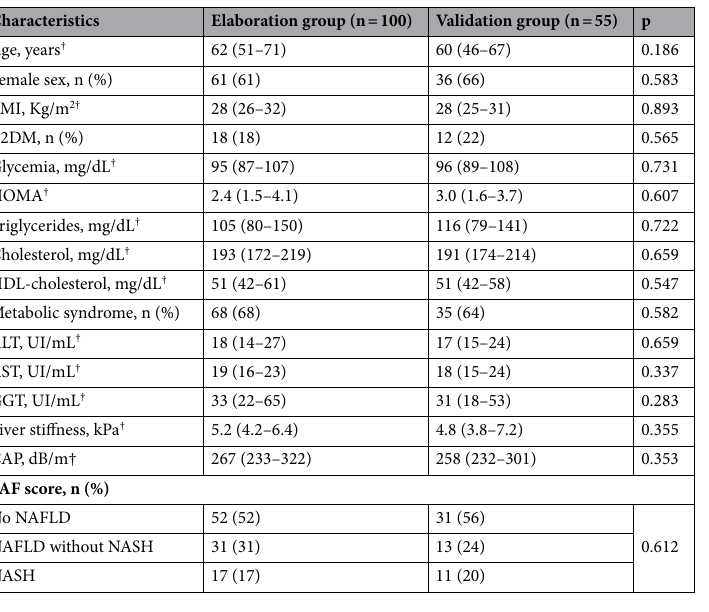
Table 3. Characteristics of the elaboration set, first 100 patients, and the validation set, remaining 55 patients. BMI Body mass index, T2DM type 2 diabetes mellitus, HOMA homeostasis model assessment. † Median (Q1-